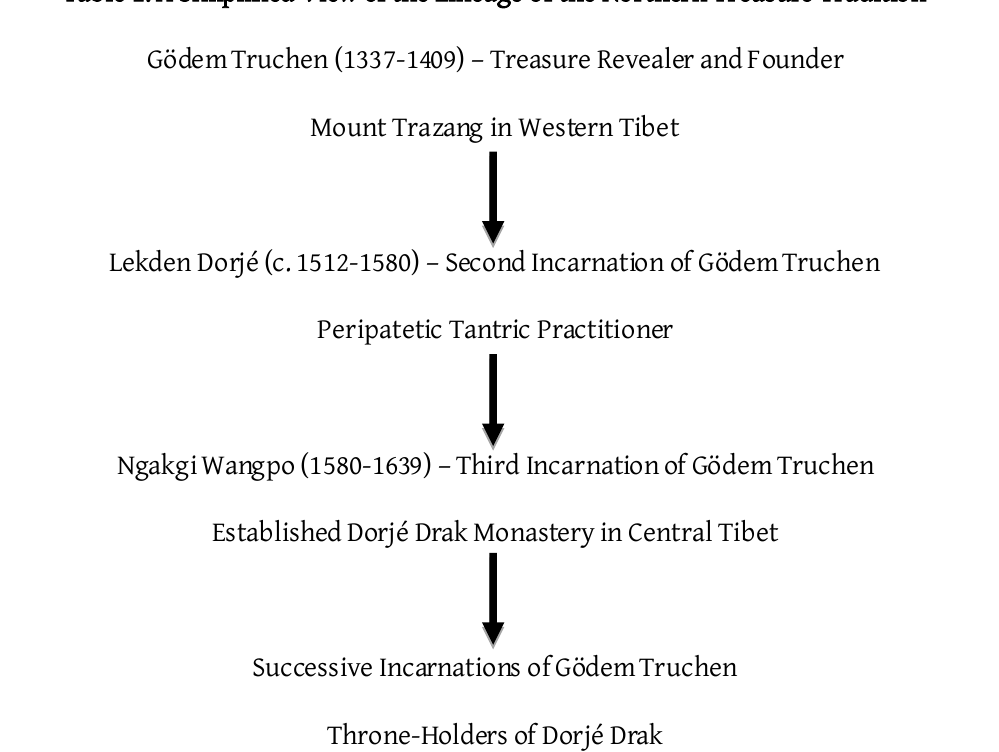
Table 1: A Simplified View of the Lineage of the Northern Treasure